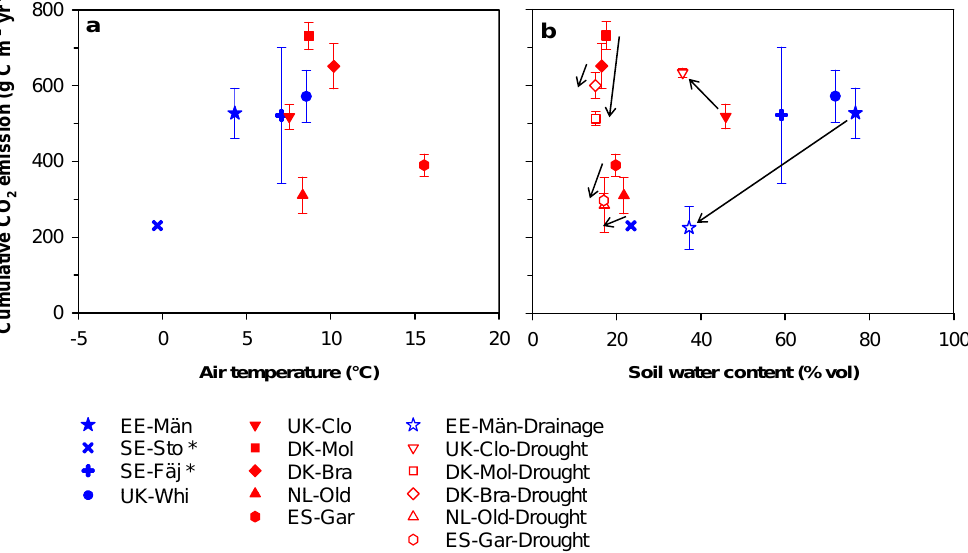
Fig. 7. Annual soil respiratory CO 2 emission in control plots at the nine sites related to mean annual air temperature (a) and mean annual soil water content, predominantly measured in the top 10cm soil layer (b) (means ± SE). In (b) , data for drained or drought treated plots are also presented with arrows indicating direction of treatment responses. ∗ Data for SE-Sto and SE-Fäj is ecosystem respiratory CO 2 emission. Site codes are described in Table